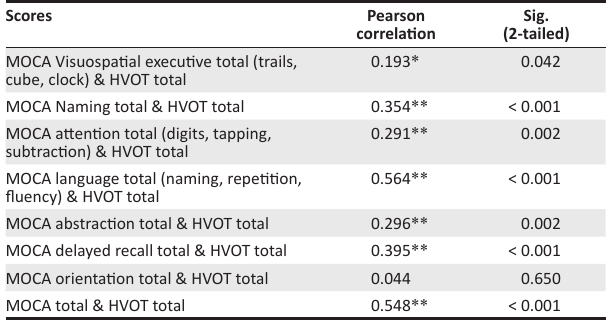
TABLE 4: Frequencies of full credit, half credit and no credit for each Hooper Visual Organization Test item.